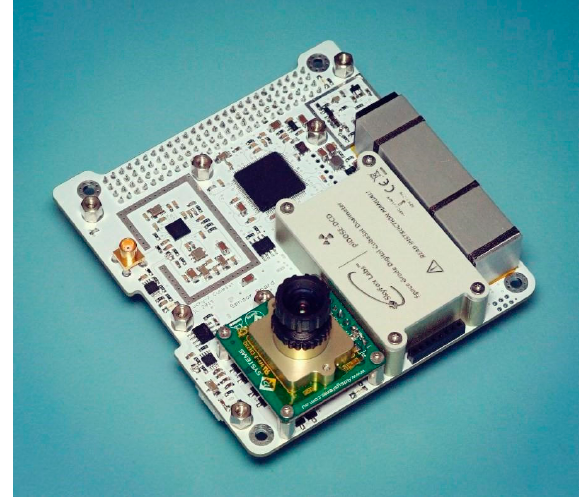
Figure 4. Scientific module.